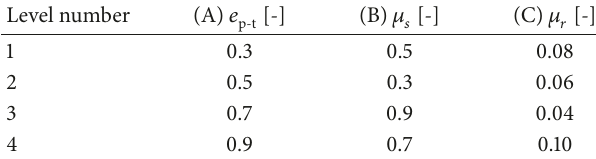
Table 2: Microcontact parameter levels in the orthogonal test.